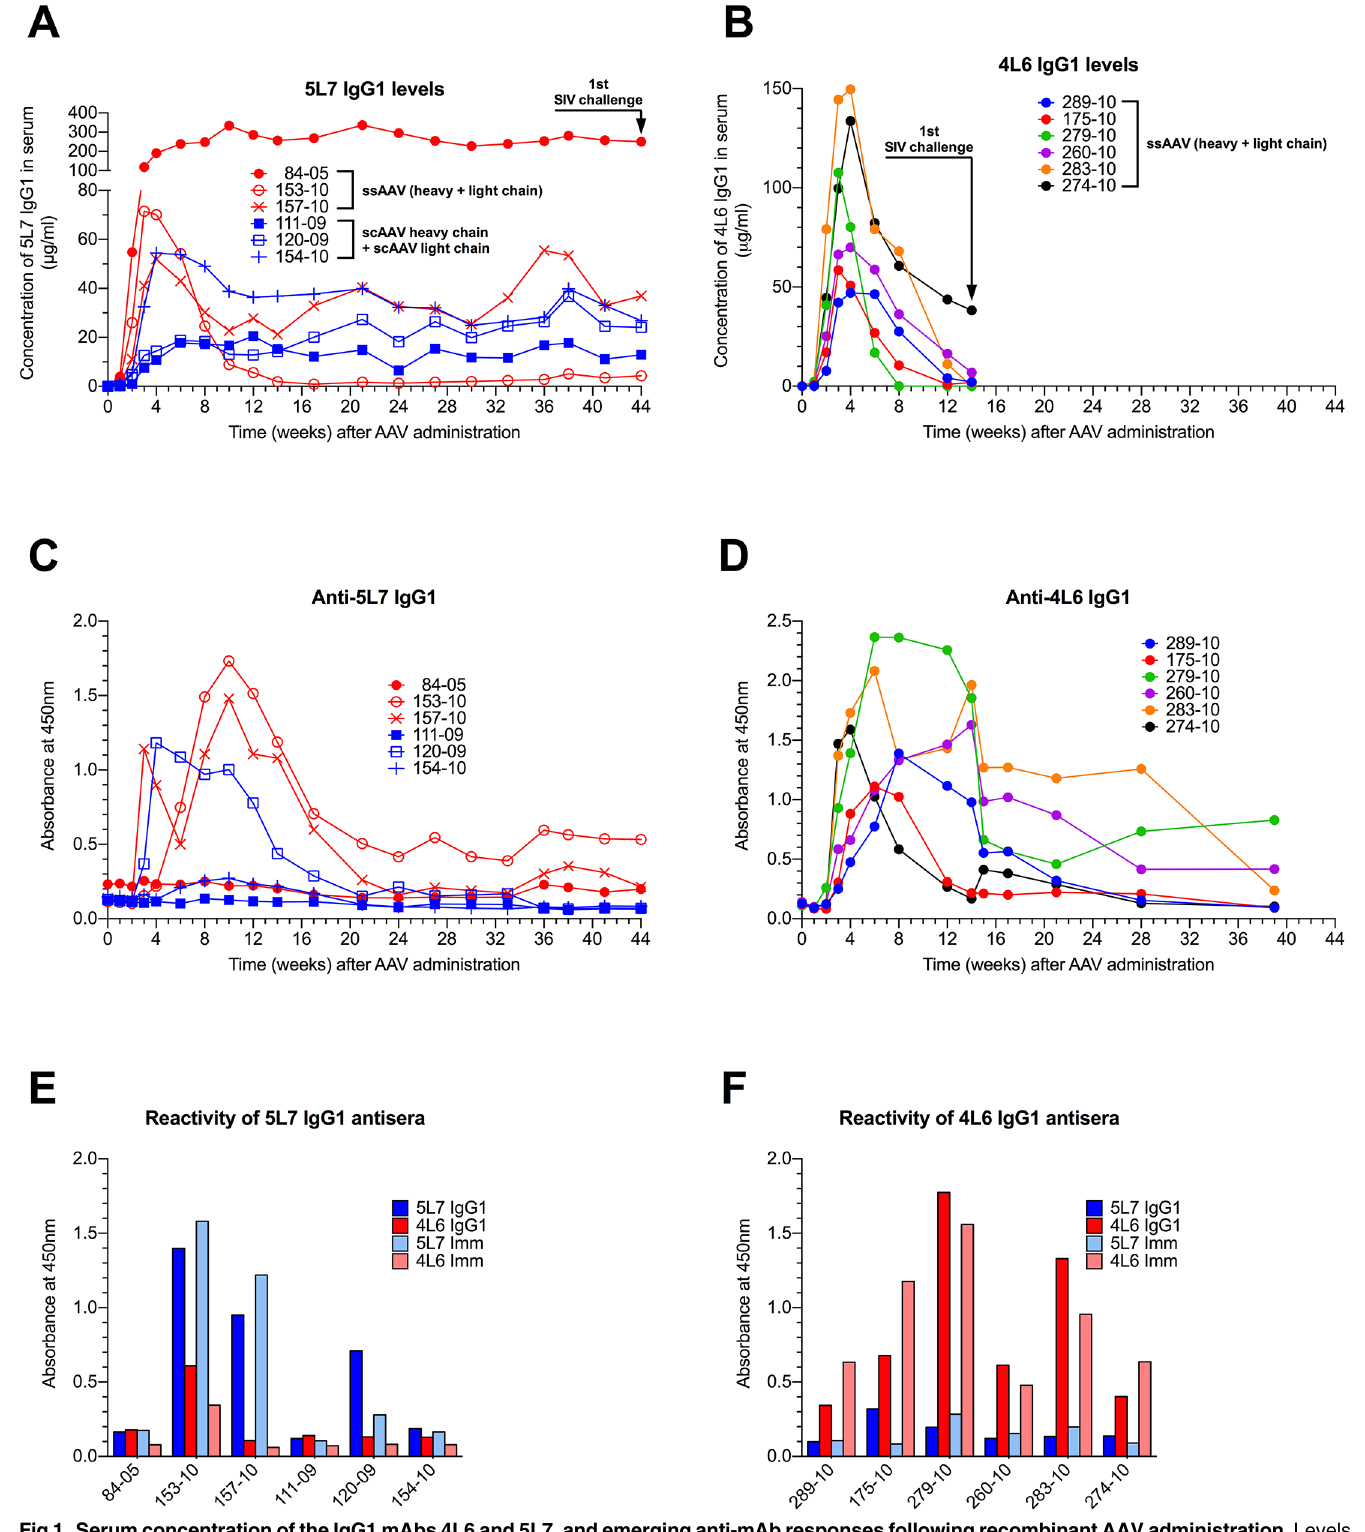
Fig 1. Serum concentration of the IgG1 mAbs 4L6 and 5L7, and emerging anti-mAb responses following recombinant AAV administration. Levels of produced antibodies were measured in sera from immunized animals over time by a gp140 capture ELISA. SIV challenge is indicated by arrows. ( A